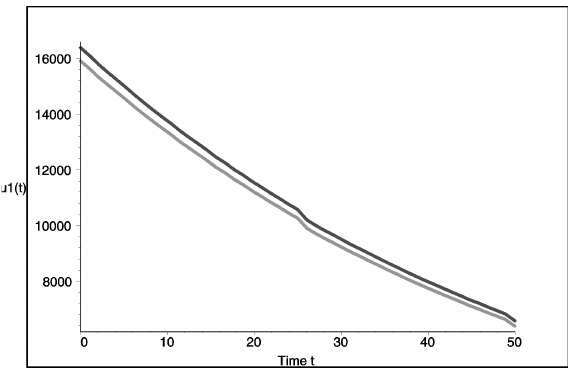
Figure 1. Population size: dark—cooperation, light—Nash equilibrium.